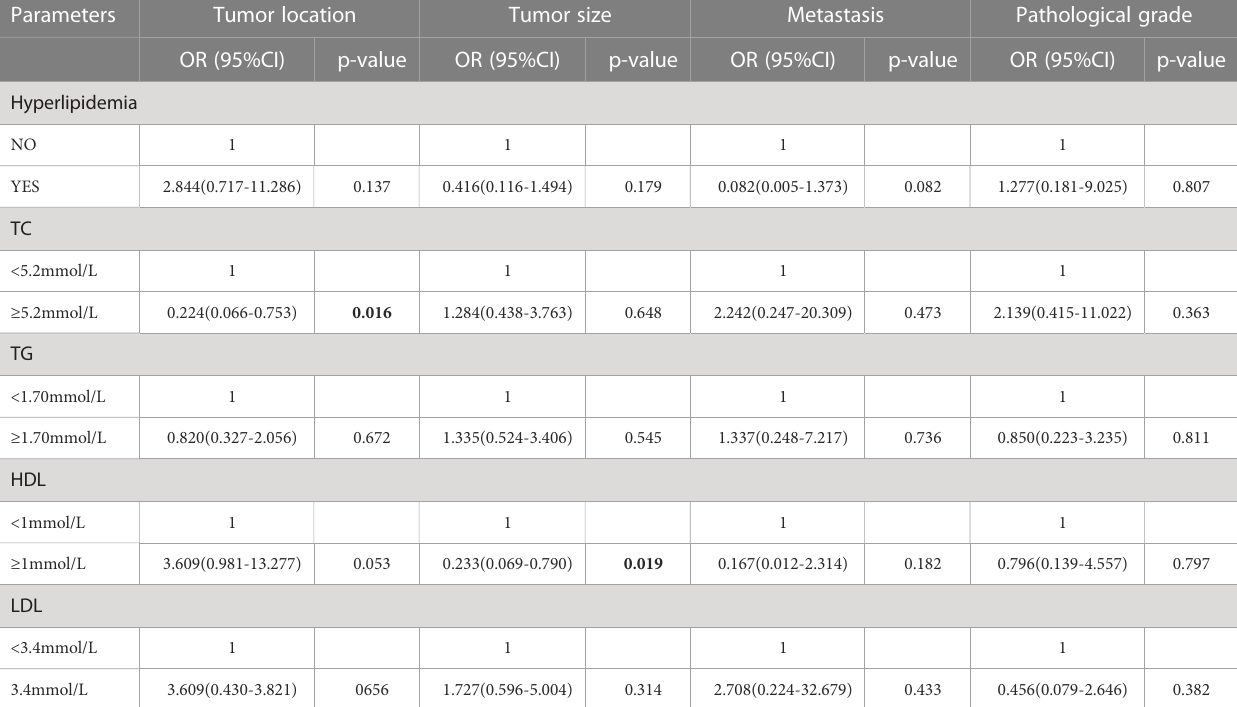
TABLE 6 The associations between serum lipids changes and clinicopathologic parameters in PanNENs.